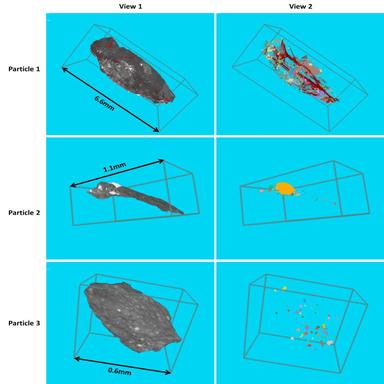
3D volume renderings of 3 selected particles. In View 1: gray color shows the minerals with Cu minerals being the brightest phase. Dark red color in Particle 1 shows the resolved fracture network within the particle. In View 2, each Cu mineral grain contained in the particle is shown by a different color with the other minerals set transparent. (For interpretation of the references to color in this figure legend, the reader is referred to the web version of this article.)